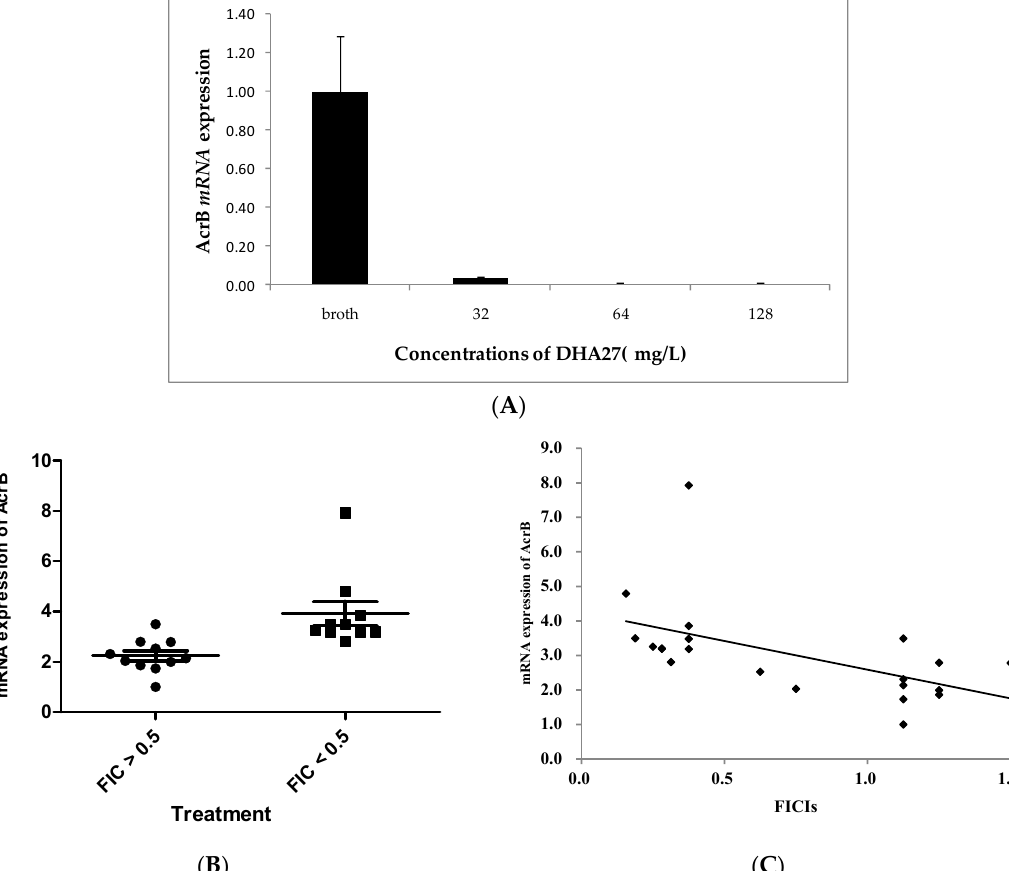
Figure 6. The effect of DHA27 on acrB mRNA expression. ( A ) The effect of DHA27 alone on the expression of acrB mRNA expression. E. coli clinical strains were treated with different concentration of DHA27 and inoculated into 50 mL of LB broth. Bacteria were cultivated at 37 °C in a heated and shaking environmental chamber of 6 h and then harvested by centrifugation at 1500 rpm for 5 min; ( B ) The AcrB mRNA expression of bacteria with FICIs > 0.5 was markedly lower than that of bacteria with FICIs < 0.5; ( C ) AcrB mRNA expression has negative correlation with antibacterial enhancement activities of DHA27 against them. E. coli clinical strains were inoculated into 50 mL of LB broth. Bacteria were cultivated at 37 °C in a heated and shaking environmental chamber to an OD 600 of 0.5 and then harvested by centrifugation at 1500 rpm for 5 min. RNA extraction and reverse transcription real-time PCR were performed. The real-time PCR products were detected using a MyiQ Color Fluorescence Real-Time Quantitative PCR kit (Bio-Rad). The gene fold changes were finally calculated according to the 2 −ΔΔ C t method for each transcript and expressed relative to the values from control group samples.